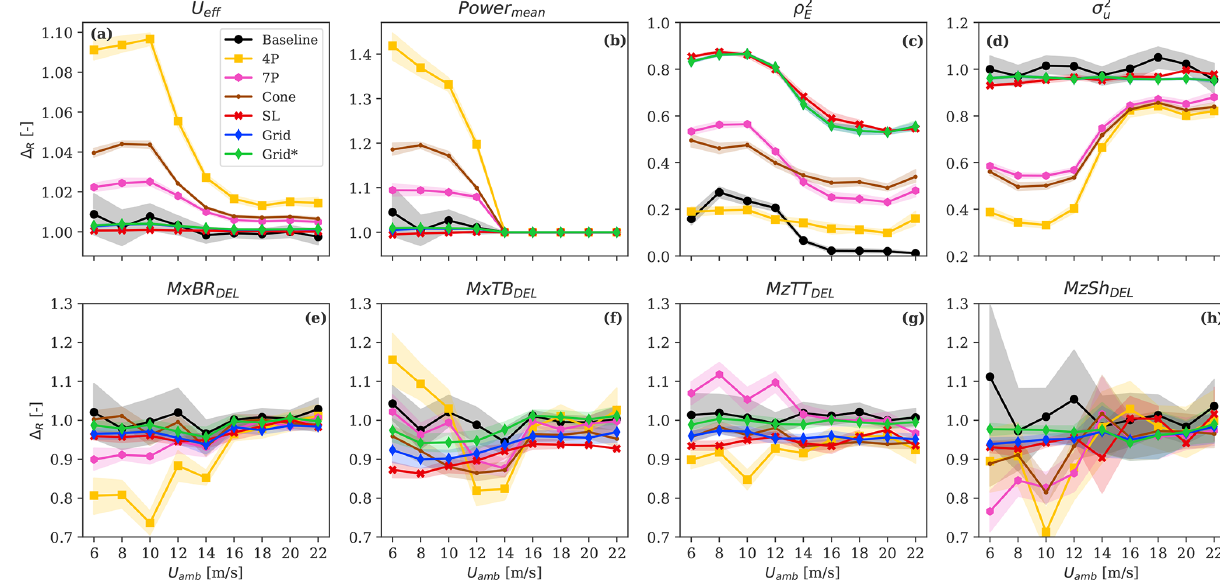
Figure 9. Comparison of bias (cid:49) R (solid line) and uncertainty X R (error band) in selected load sensors as a function of the ambient wind speed. The uncertainty indicators are computed against the target observations for each ambient wind speed (marker) that consists in 18 aeroelastic simulations with random turbulence field realizations. The lidar-based results are derived from simulations with CS